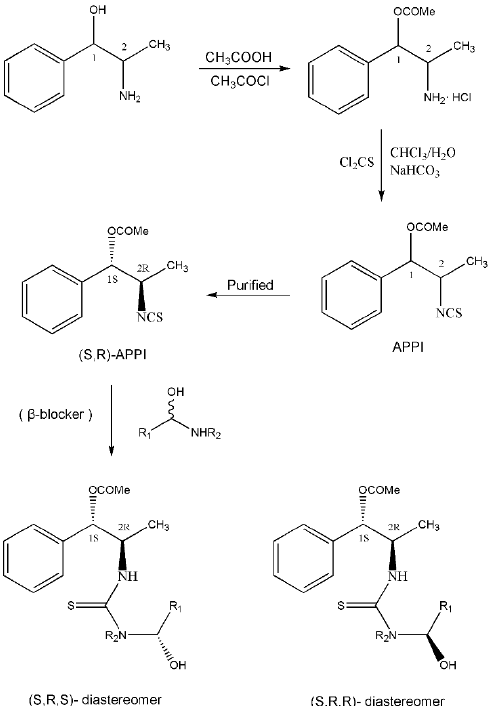
Figure 2. The preparation procedure of (S,R)-APPI and synthesis of diastereomers of β -blockers [98]. Beyond that, Sung et al. [100] applied S -(-)-menthyl chloroformate((-)-MCF) as the chiral derivatization reagent, combined with hydrolysis, to resolve stereoisomers of nadolol with three chiral centers and finally obtained the most active one R,S,R -(-)-nadolol with very good optic purity (99.97%).